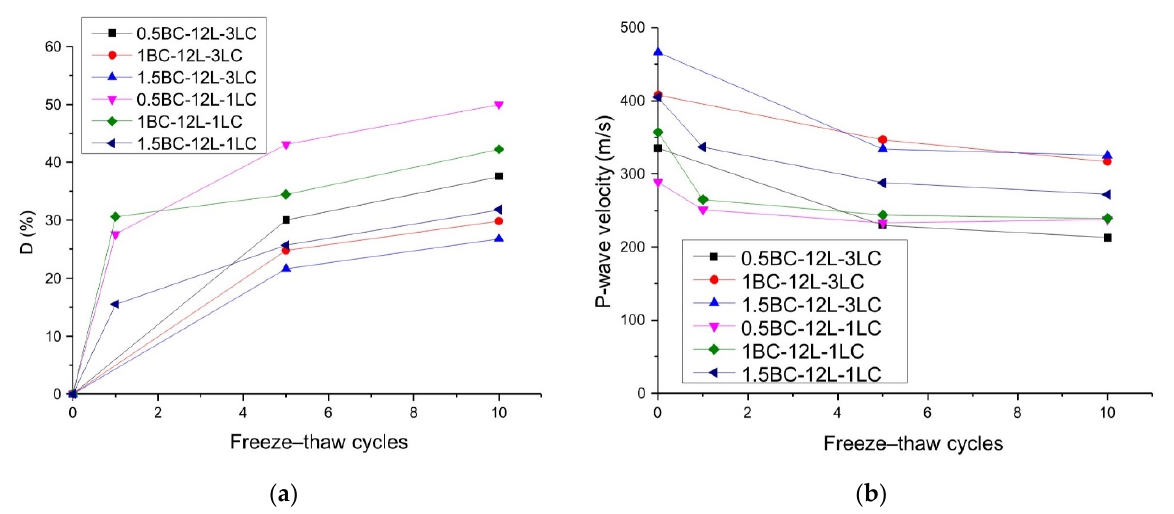
Figure 11. Effects of lime content and freeze–thaw cycles on freeze–thaw damage and wave velocity with 12 mm fiber length: ( a ) freeze–thaw damage D; and ( b ) P-wave velocity.